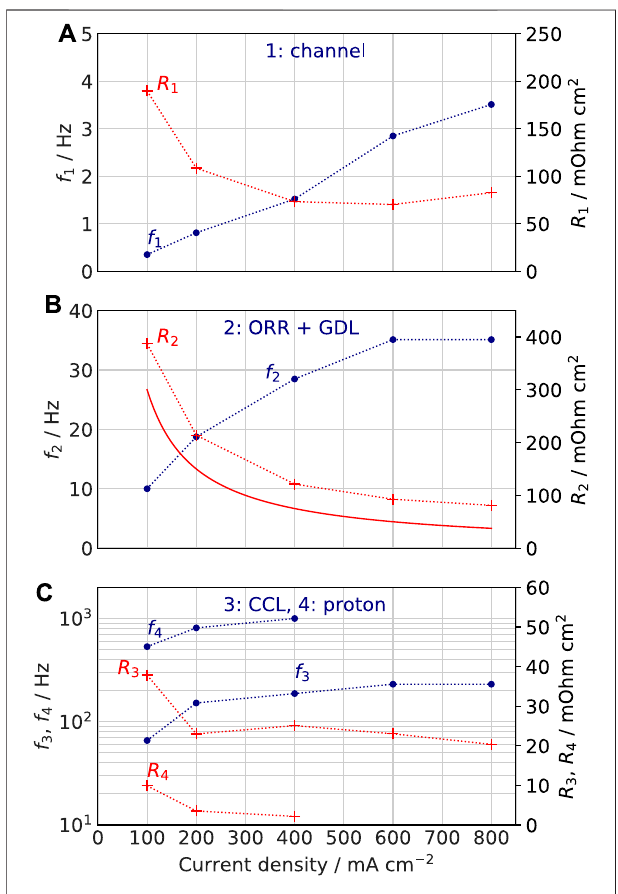
FIGURE 6 | Frequency (blue curves, left axis) and resistivity (red curves, right axis) of the DRT peaks calculated using RC kernel ( Figure 5 ) versus mean cell current density J . (A) fi rst peak, (B) second peak and (C) third and fourth